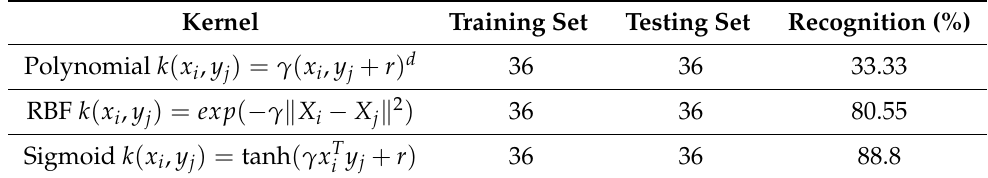
Table 4. Multivariate Pattern Recognition (MVPR) using different kernels and D 2 from C . Kernel Training Set Testing Set Recognition